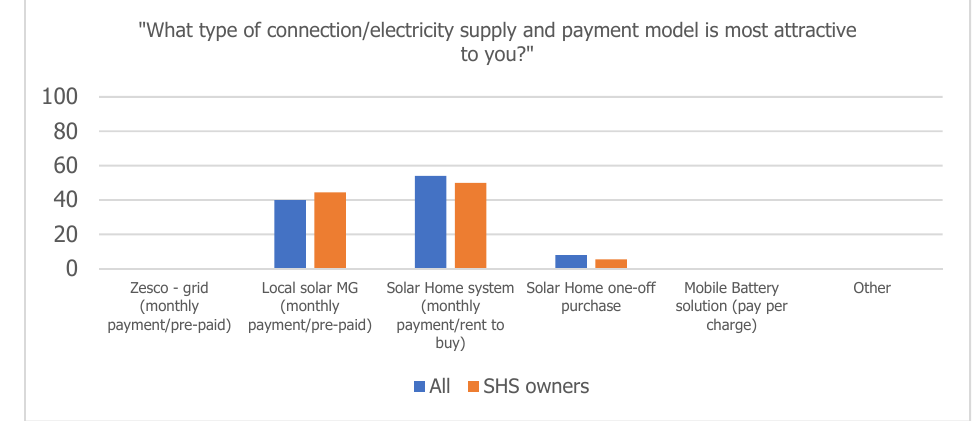
Figure A4. Desired energy connection, Southern Zambia, N = 50, Responses in %.